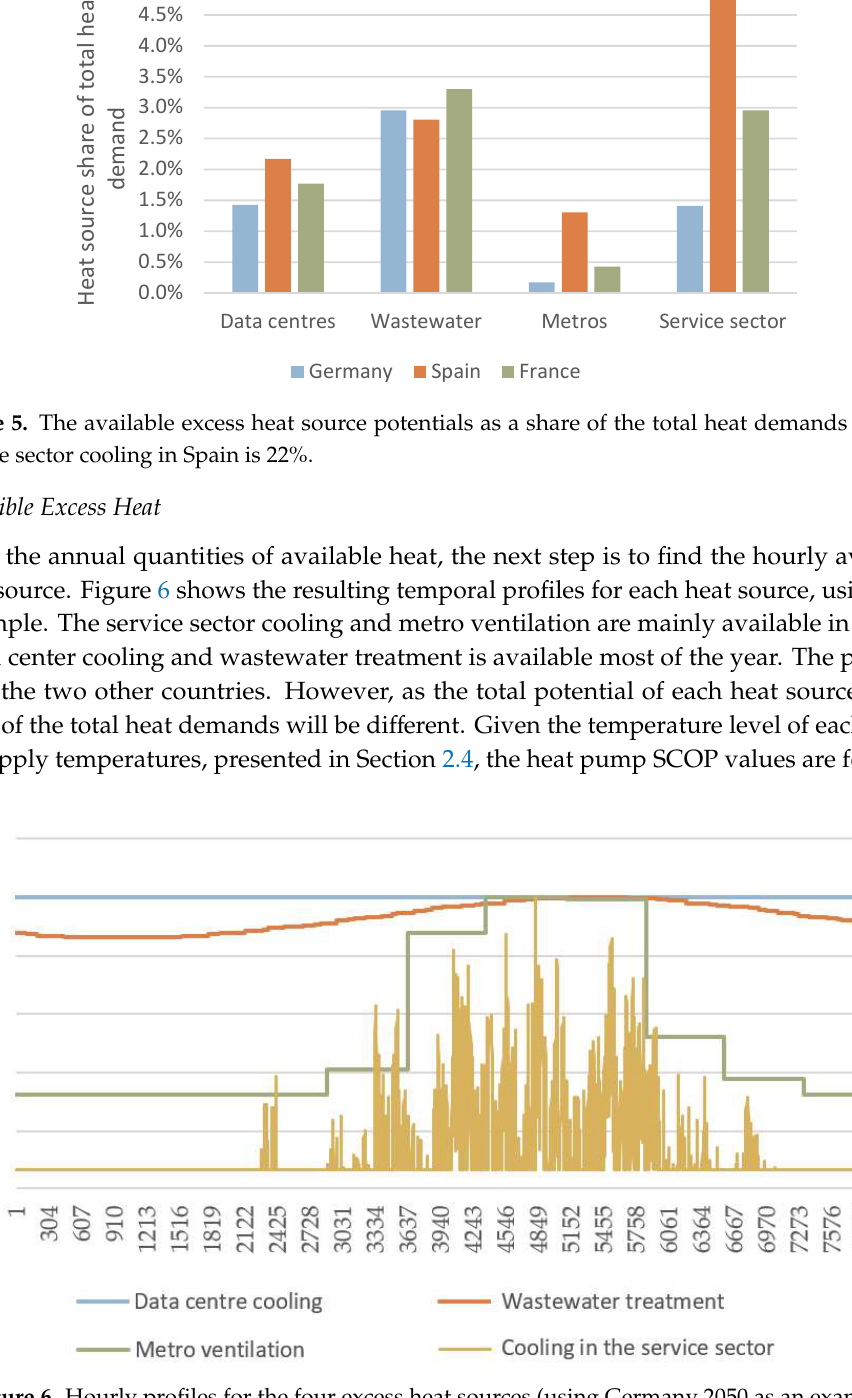
Figure 6. Hourly profiles for the four excess heat sources (using Germany 2050 as an example).